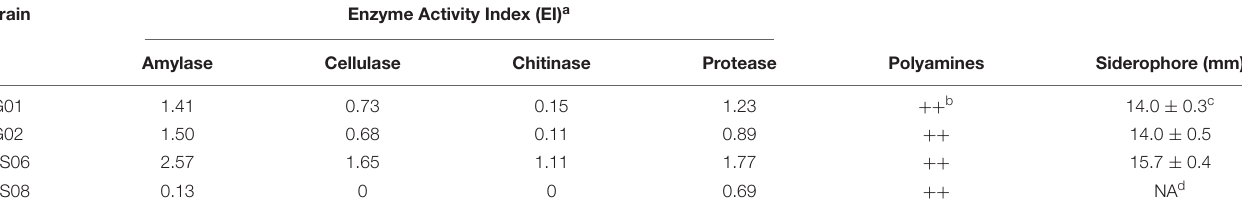
TABLE 5 | Enzyme activity indexes and polyamine and siderophore production by the four Streptomyces strains. Strain Enzyme Activity Index (EI) a Amylase Cellulase